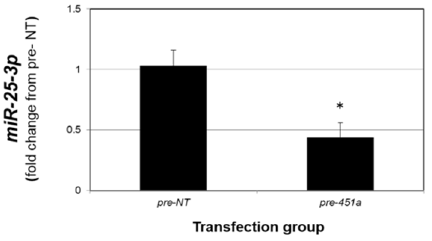
Figure 5. miR-451a decreases miR-25-3p expression in endometriotic epithelial 12Z cells. Aster- Figure 5. miR ‐ 451a decreases miR ‐ 25 ‐ 3p expression in endometriotic epithelial 12Z cells. Asterisk indicates statistically significant ( p < 0.01) reduction compared to pre ‐ NT transfected cells. N = 3 isk indicates statistically significant ( p < 0.01) reduction compared to pre-NT transfected cells. replicates. N = 3 replicates.